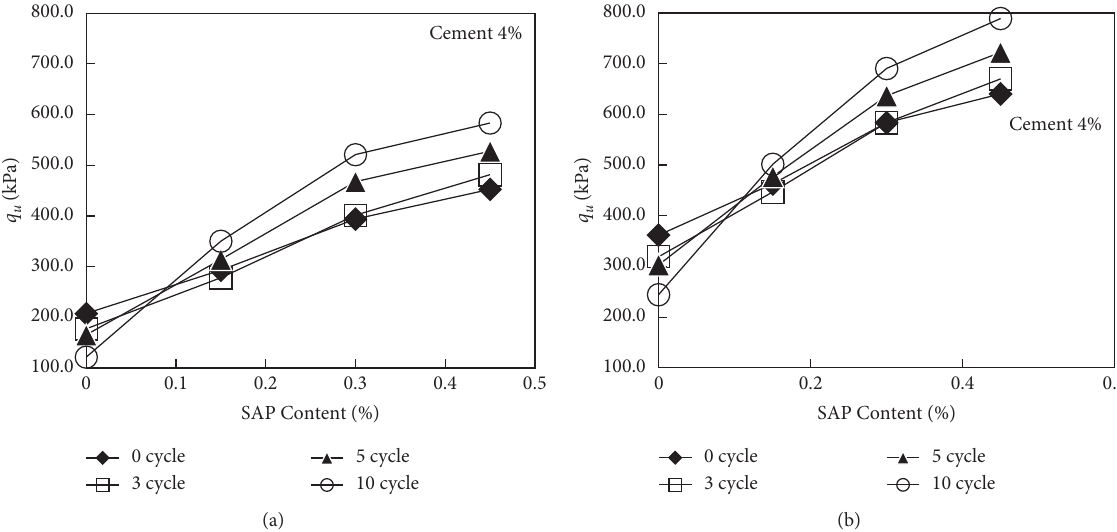
Figure 6: Influence of the SAP content on the compressive strength of the cement excavated soil for W-D cycles. (a) 7 days. (b) 28